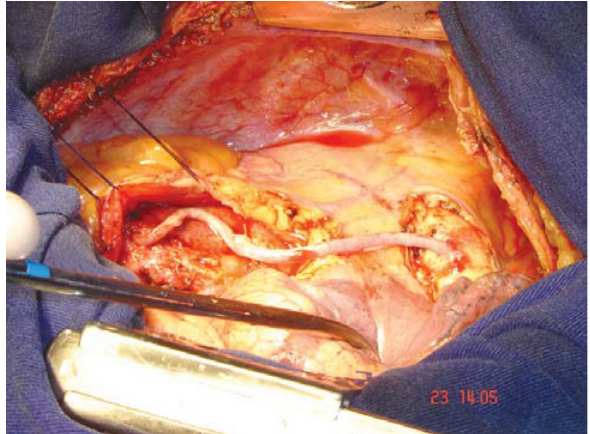
Fig. 5 - Aspecto final da ponte de safena, observando-se as anastomoses na artéria circunflexa e na aorta